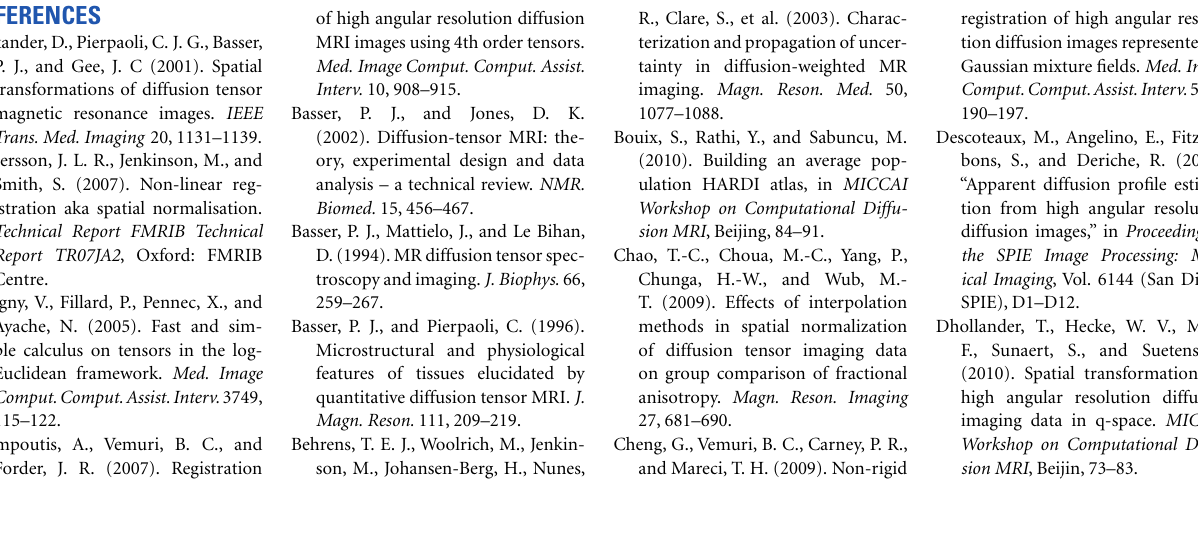
(NIBIB), the Human Connectome Project (U54